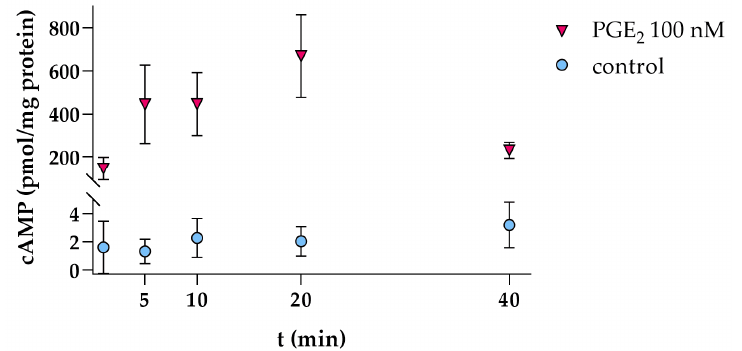
Figure 1. Intracellular cAMP levels in hPC are increased by PGE 2 stimulation (100 nM, pink triangles) in a time-dependent manner. For several controls (blue circles), cAMP levels fell below the lowest concentration of the recommended standard curve (0.78 pmol/mL) and were therefore set to zero. Each data point represents the mean ± SD of one experiment with n = 3–4 samples per time-point.